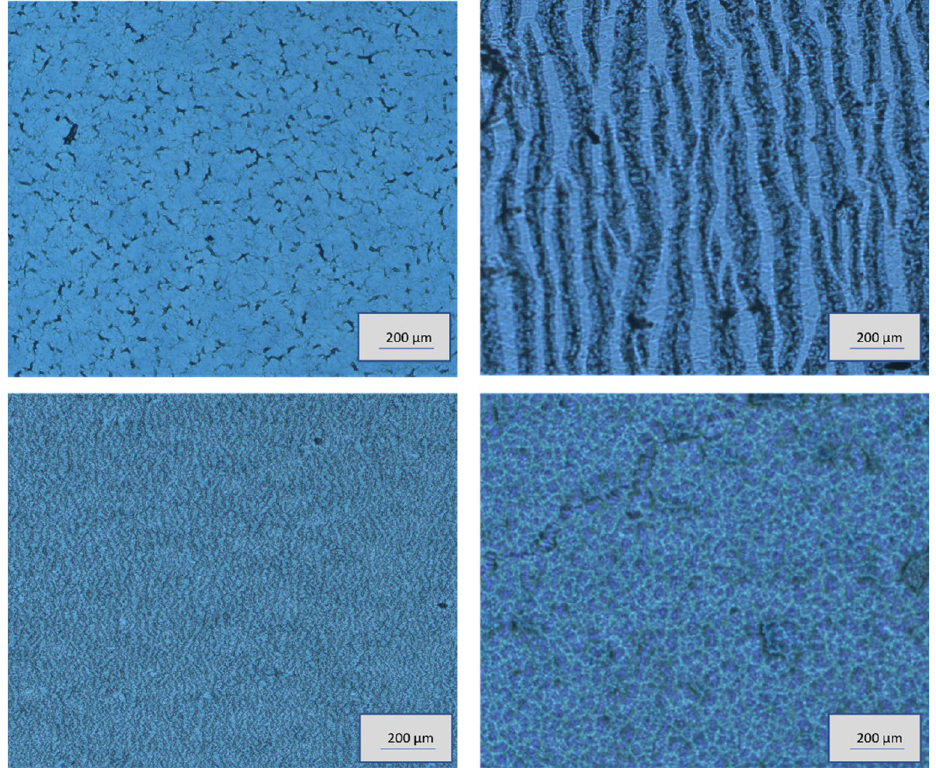
Figure 3. Microscopic images of PEDOT:PSS layers with varying proportions of stretching enhancers kept for stretching. Layer morphology of PEDOT:PSS composition with no addition of stretchability enhancers ( a ), after stretching it to 100% strain value ( b ), the resultant layer of PEDOT:PSS with stretchability enhancer of 5wt% and 15wt% respectively at 100% strain condition ( c , d ).